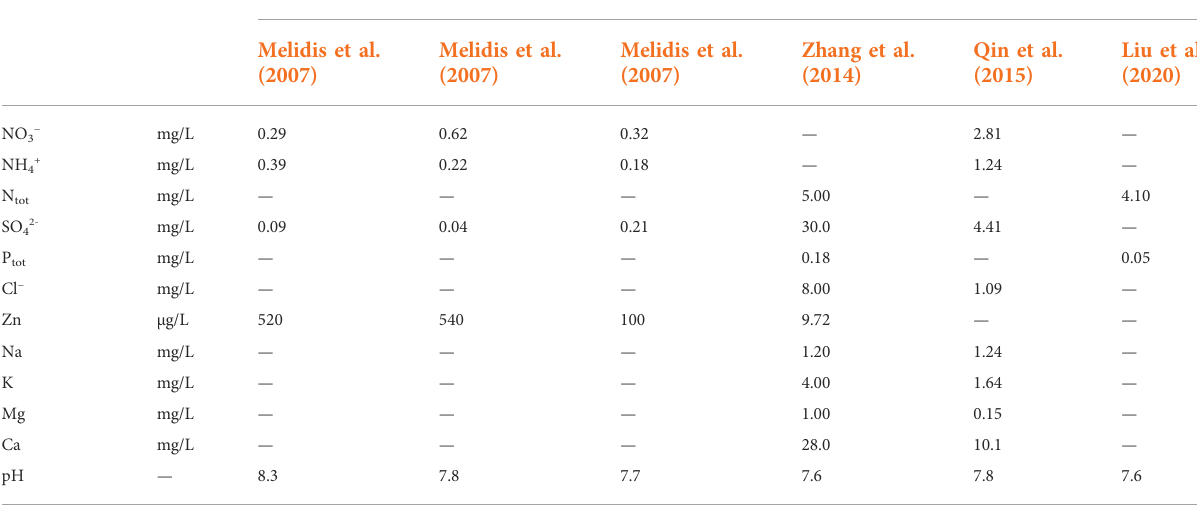
TABLE 4 Mean values of different parameters in concrete fl at roof runoff.